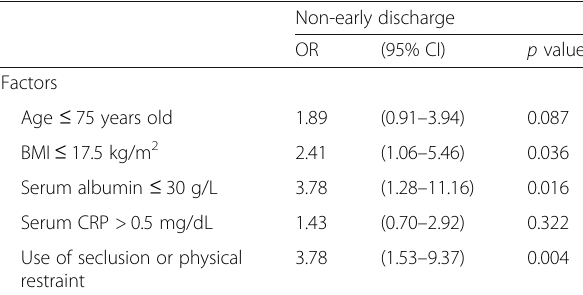
Table 3 Odds ratios (OR) and 95% confidence intervals (95% CI) for various factors associated with non-early discharge